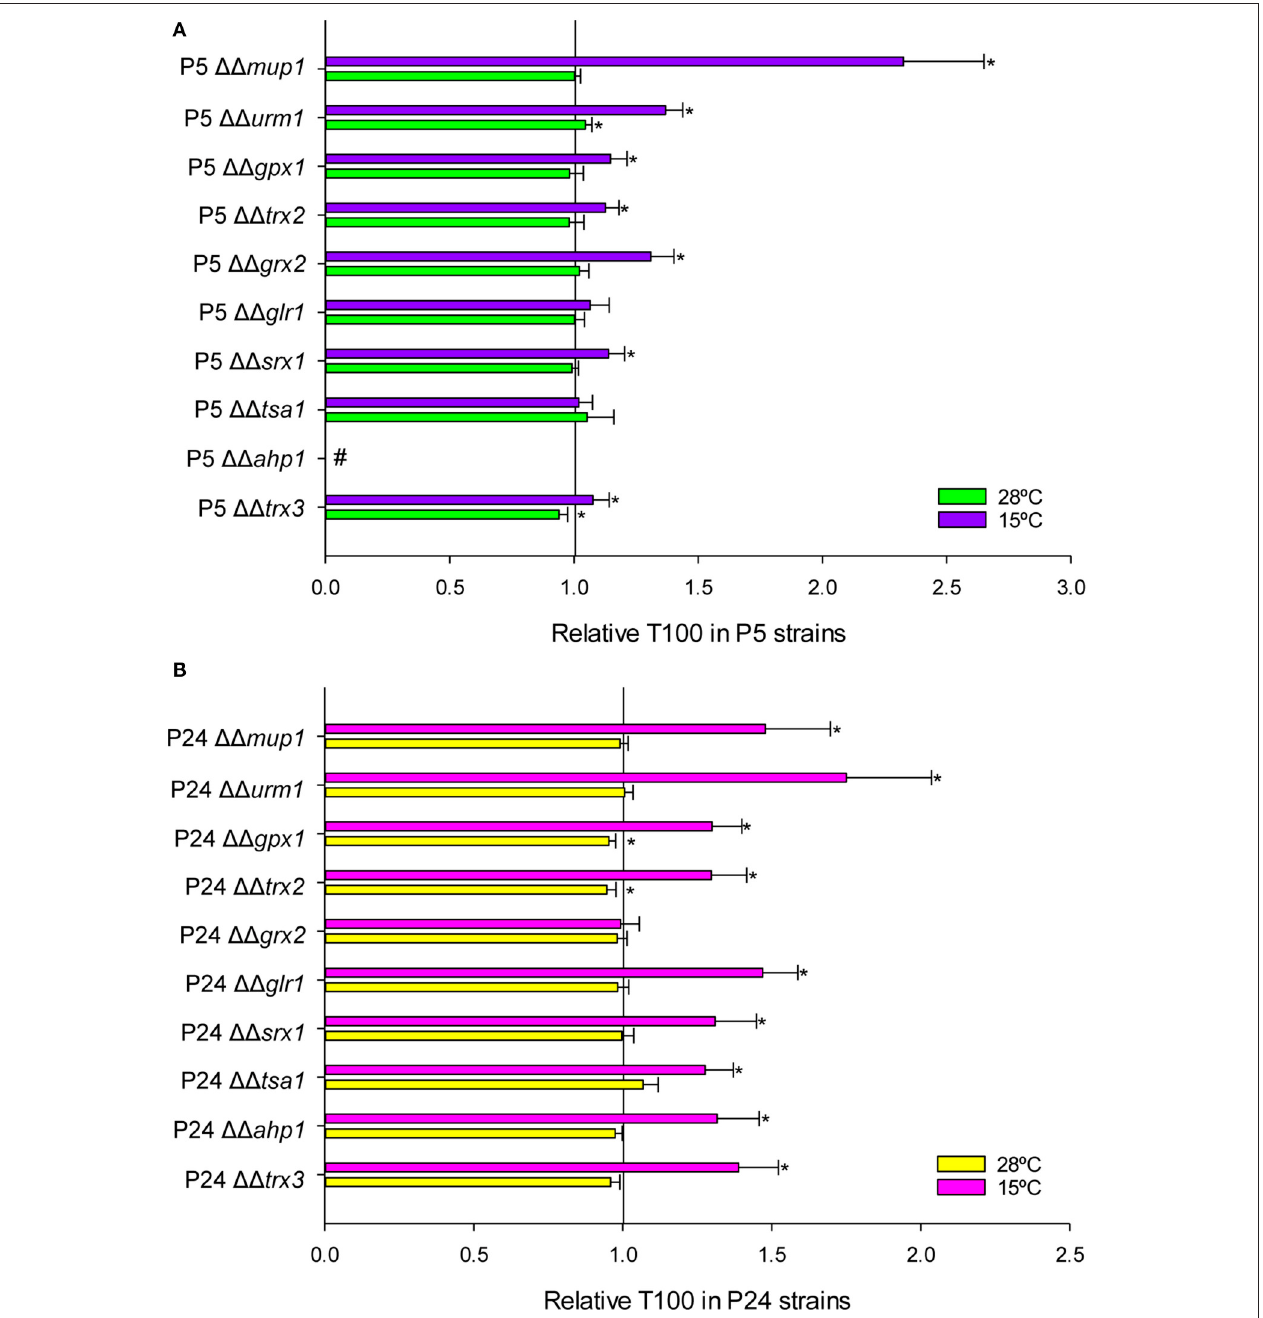
FIGURE 5 | Fermentation kinetics in the mutant strains constructed in P5 (A) and P24 (B) at 15 and 28 ◦ C. T100 is the time needed to consume the total amount of sugars present in the must. The T100 value was compared with the control normalized as value 1. *Significant differences ( p ≤ 0.05) compared with the control at the same temperature. # Indicates a stuck fermentation before